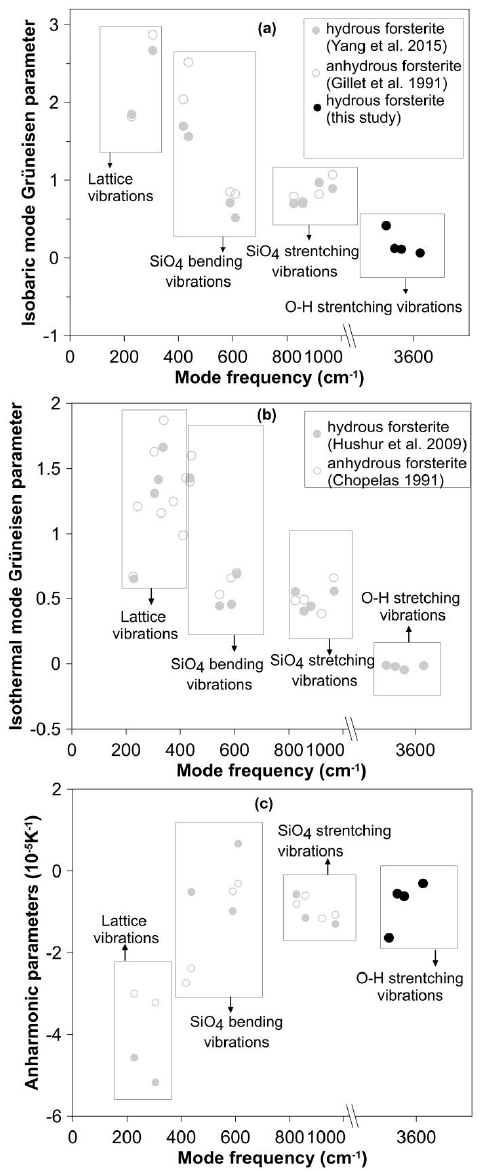
Figure 9. The isobaric ( a ), isothermal ( b ) mode Grüneisen parameters and intrinsic anharmonic parameters ( c ) for the anhydrous [50,66] and hydrous foresterite, calculated from the Raman measurements at high temperature (this study and Yang et al. [57]) and high pressure [24].